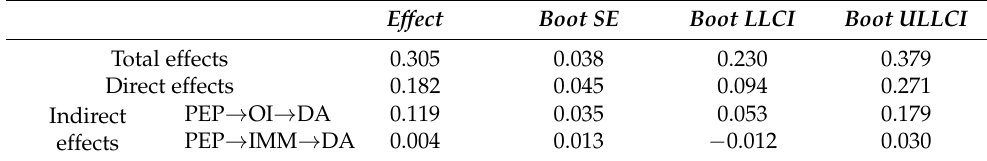
Table 4. Total, direct, and indirect effects of PEP on deep